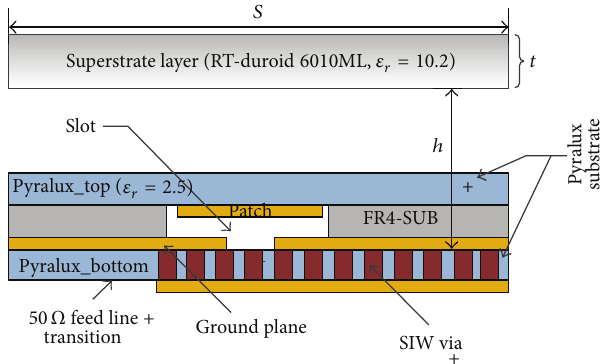
Figure 7: Cutting plane of a membrane antenna with superstrate layer, ground plane size 10 × 10 mm 2